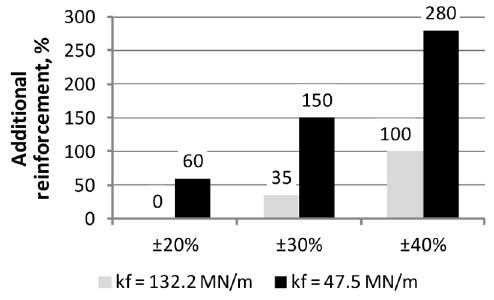
Fig. 15. Additional reinforcement in the bottom of the floor slab